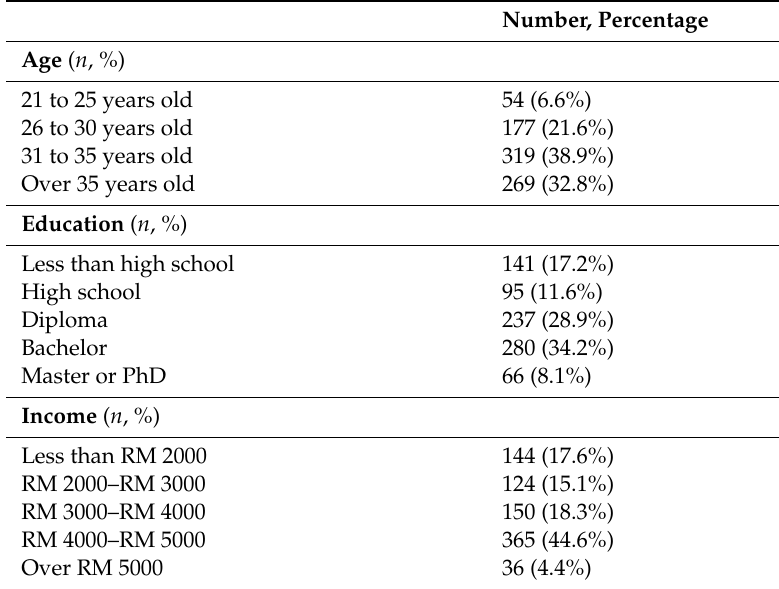
Table 1. Descriptive statistics of research